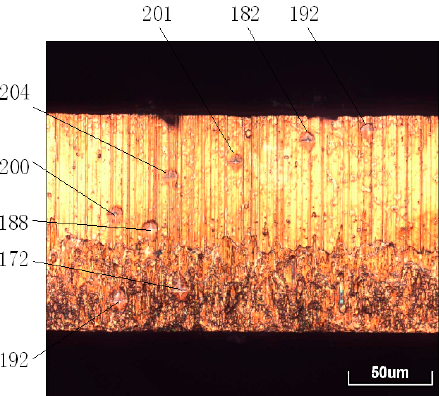
Figure 4. Microhardness of the blanked edge of phosphor bronze sheet (Units: HV).